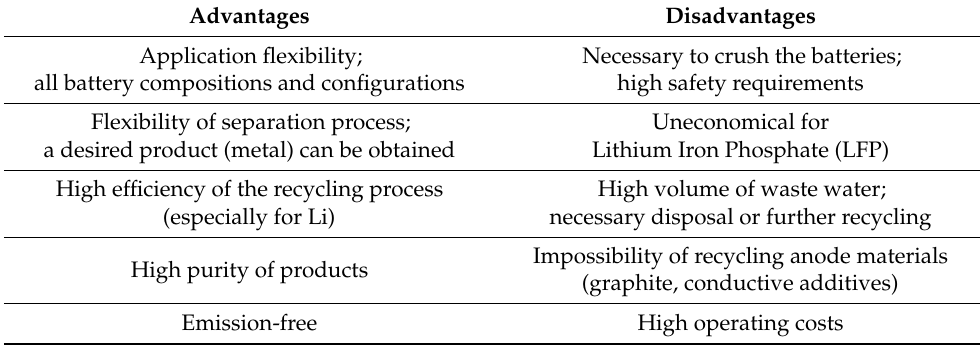
Table 7. Advantages and disadvantages of hydrometallurgical process according to